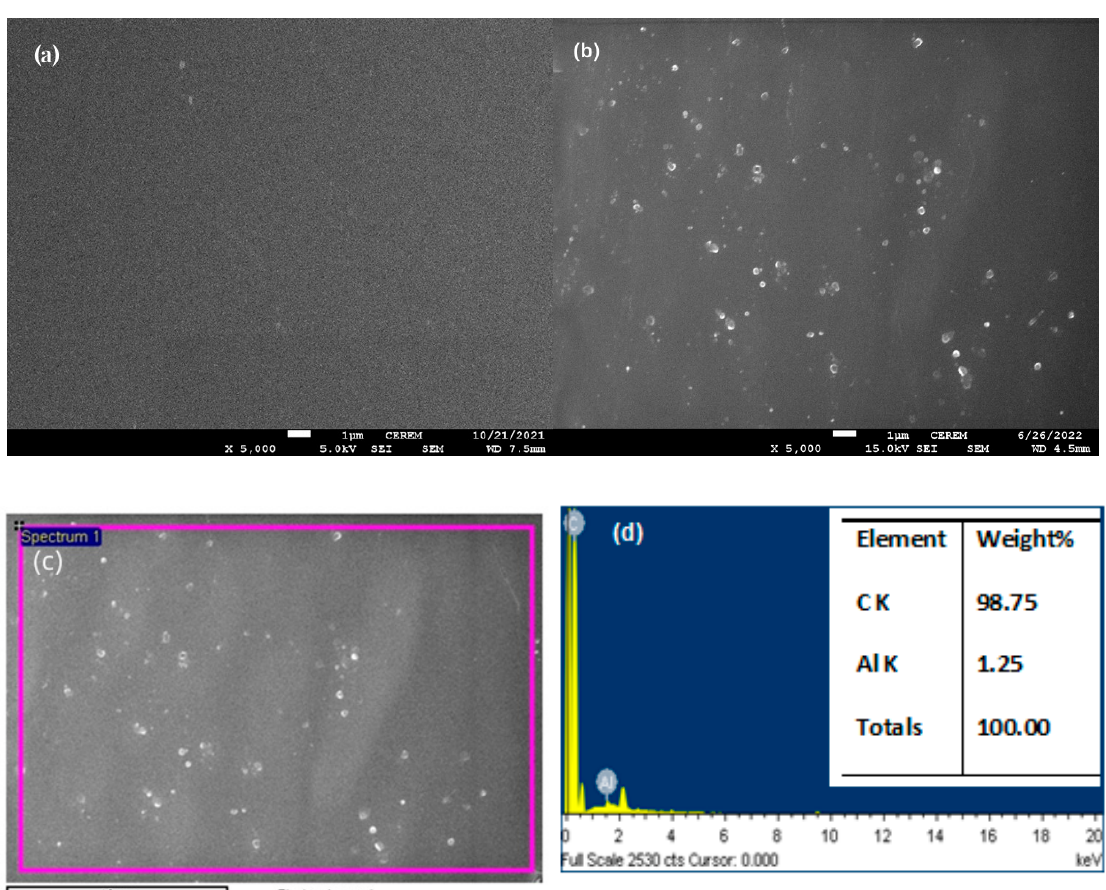
Figure 2. SEM images of neat epoxy-coated ( a ) and 1% Al-coated ( b ) samples along with EDX elemental analysis ( c , d ).